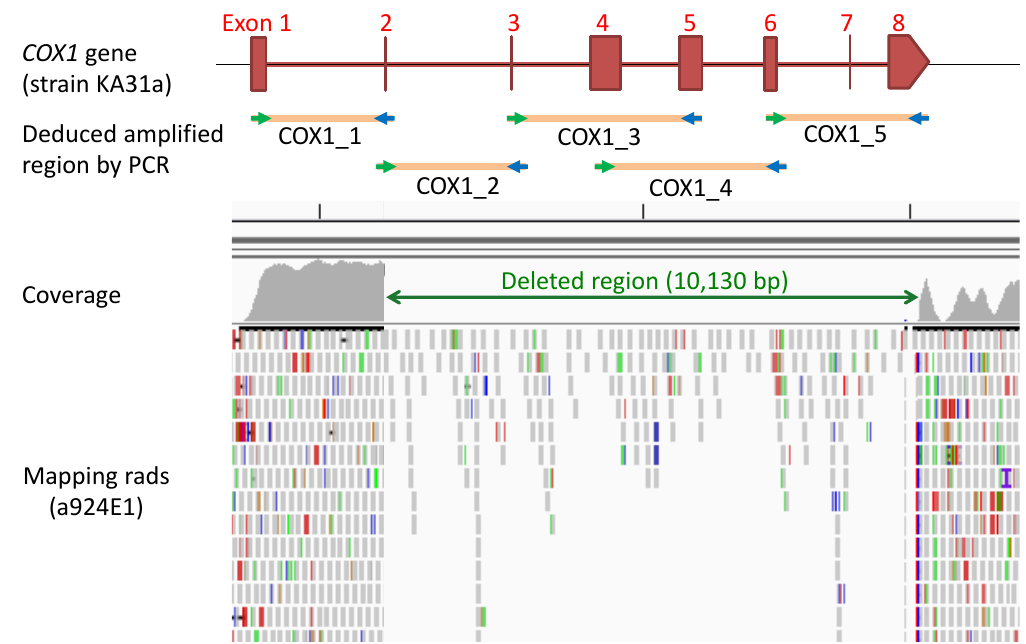
Figure 3. The deleted region in mitochondrial DNA of strain a924E1. Mapping rads of the short reads with coverage are shown. The alignment matches are highlighted in gray and mismatches in different colors (red bars are deletions, blue bars are insertions, green bars are tandem duplications). The map of COX1 gene in strain KA31a and PCR primer positions with deduced amplified regions are also shown.